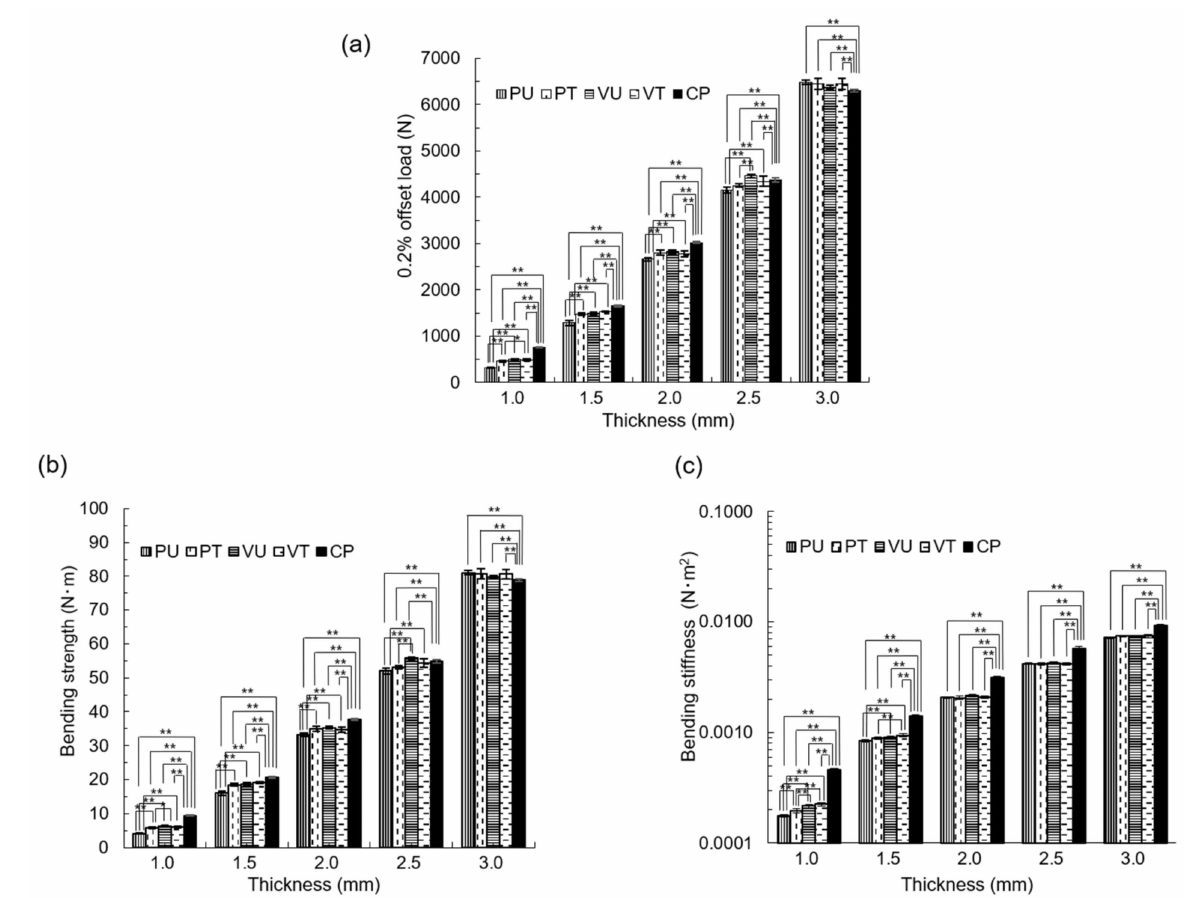
Figure 5. Static bending test results. ( a ) 0.2% offset load. ( b ) Bending strength. ( c ) Bending stiffness. * p < 0.05, ** p <